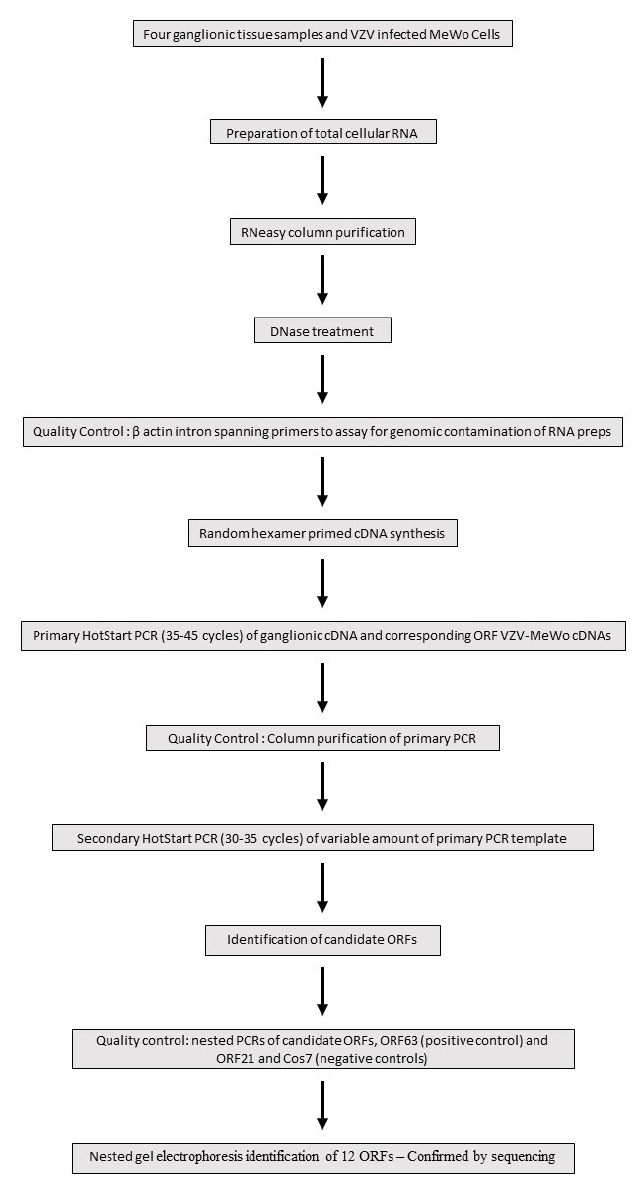
Figure 1. Flow chart depicting key stages in the nested PCR analysis to identify VZV genes expressed in ganglionic tissue.